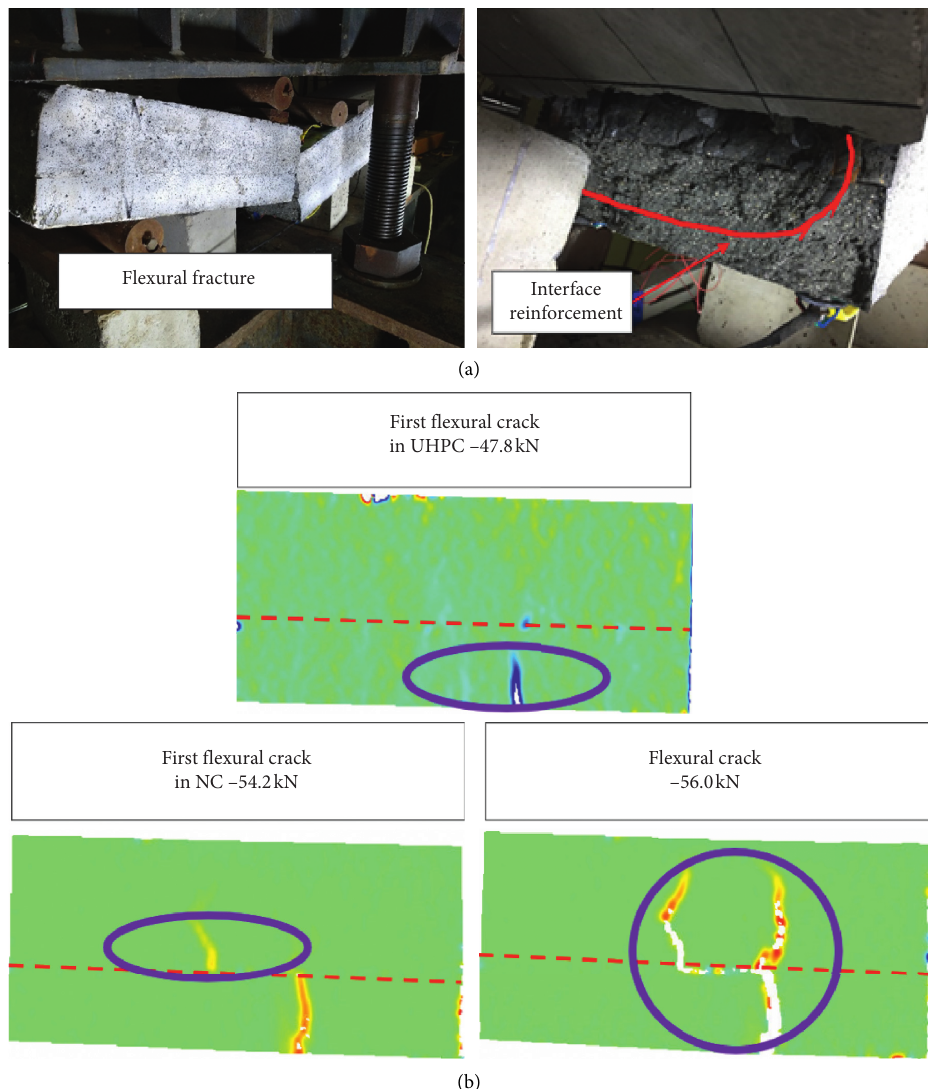
Figure 15: Failure patterns and damage evolutions of specimen U60-S. (a) Photos for failure pattern. (b) Damage tracking with DIC